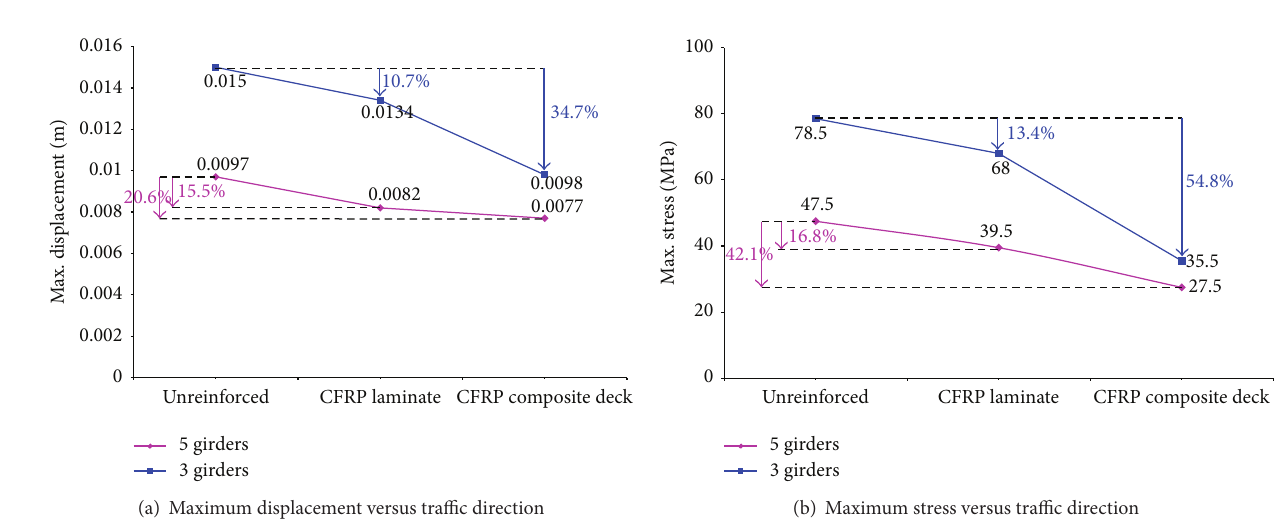
Figure 13: Schematic of dynamic responses of undamaged composite bridges.